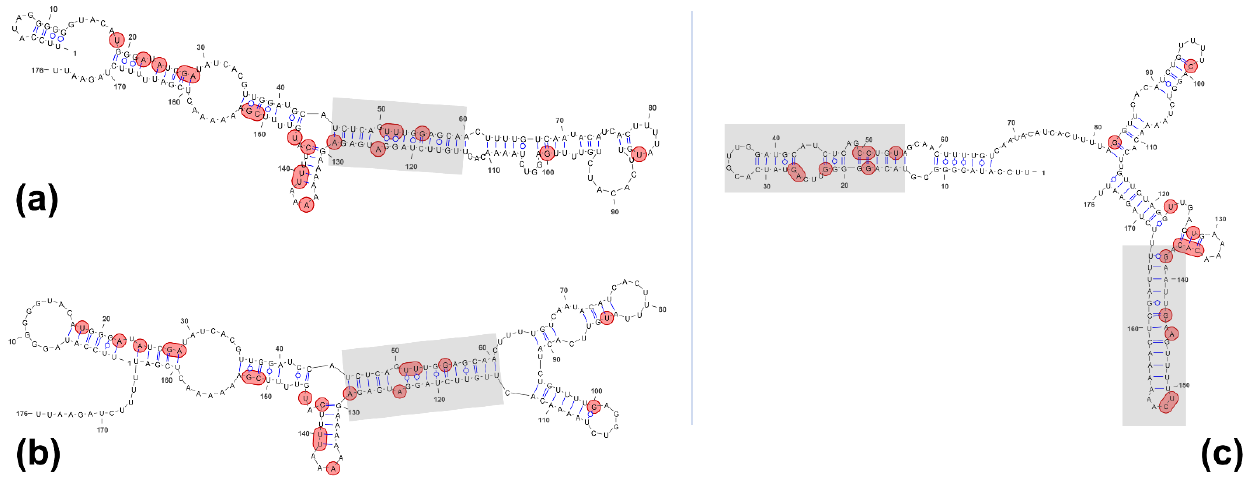
Figure 3. Minimum free energy (MFE) structures predicted with RNAStructure 6.0.1. ( a ) CriTER-A MFE at 20 °C; ( b ) CriTER-A MFE at 35 °C; ( c ) CriTER-B MFE. No significant temperature-dependent changes are found in MFE structures predicted for CriTER-B. Sequence variations are denoted in red. Regions with high base pairing probabilities and highly prevalent in the suboptimal spaces are shadowed (see Supplementary Materials).